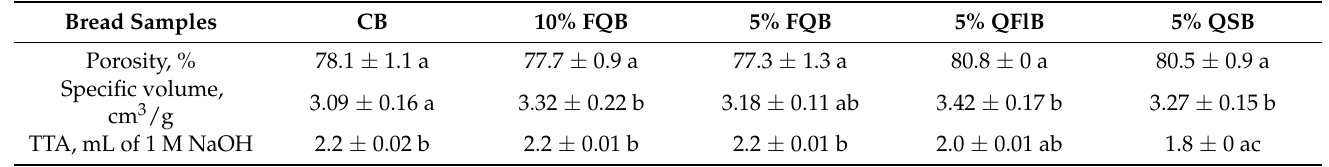
Table 4. Characteristics of quinoa-wheat composite